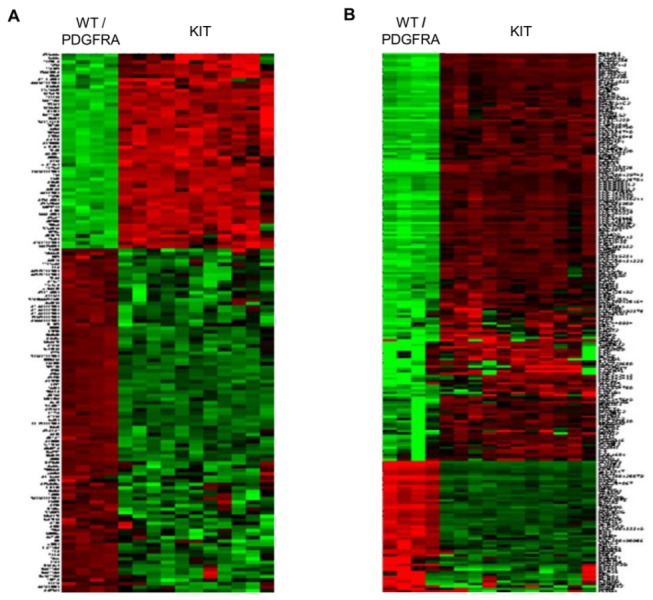
Heat map of differentially expressed genes after quantile (A) and VSN (B) normalization.